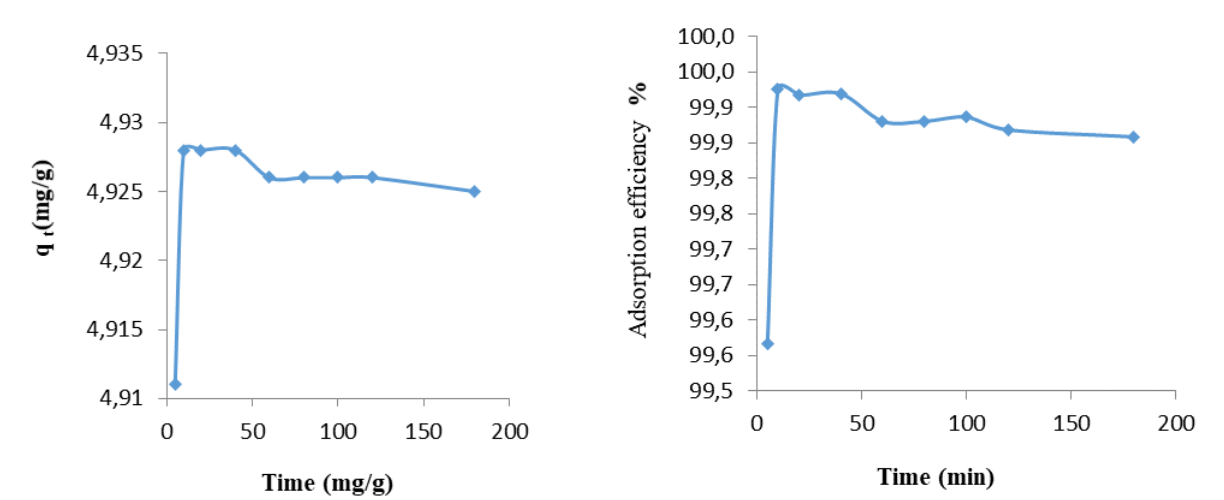
Fig. 5. The adsorbed amount (q t ) of Cd 2+ ions were removal adsorbed onto SEZ at 10 mg/L of Cd 2+ (25± 0.2 o C)